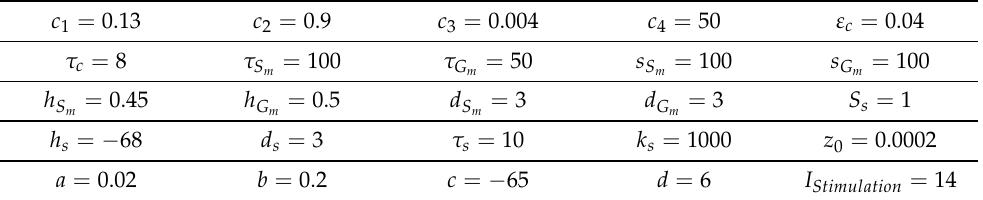
Table 1. Different Parameters of the CNS